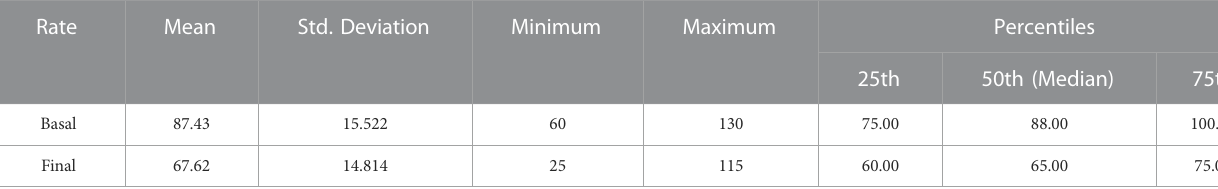
TABLE 4 Ventricular rate changes before and after Remdesivir administration.